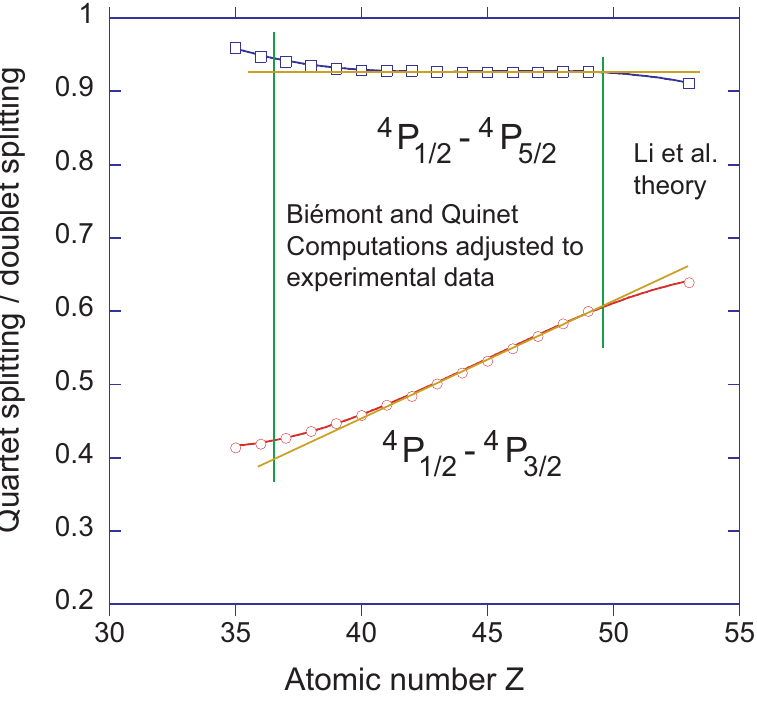
Figure 6. Relative fine structure splitting of the 4s4p 2 4 P term and the 4s 2 4p 2 P o ground term in Ga-like ions. For the ground term fine structure, the experimental data compilation by Curtis and Reader [92] has been fitted by a polynomial and extrapolated. For the quartet term, the semi-empirically adjusted computation by Biémont and Quinet [69] is depicted ( Z = 37 up to Z = 49); the entries for Z = 53 represent the computation by Li et al. [57]. The straight curry-color lines approximate the experimental data in the center part of the figure. The isoelectronic data including those for low- Z and for Z = 53 have been approximated by third-degree polynomials (blue and red traces, respectively). The curvature at the high- Z end of both trends is not evident in the data below Z = 50, but apparently entirely caused by a small inconsistency between the experimental data (for Z ≤ 49) and computation (for Z =